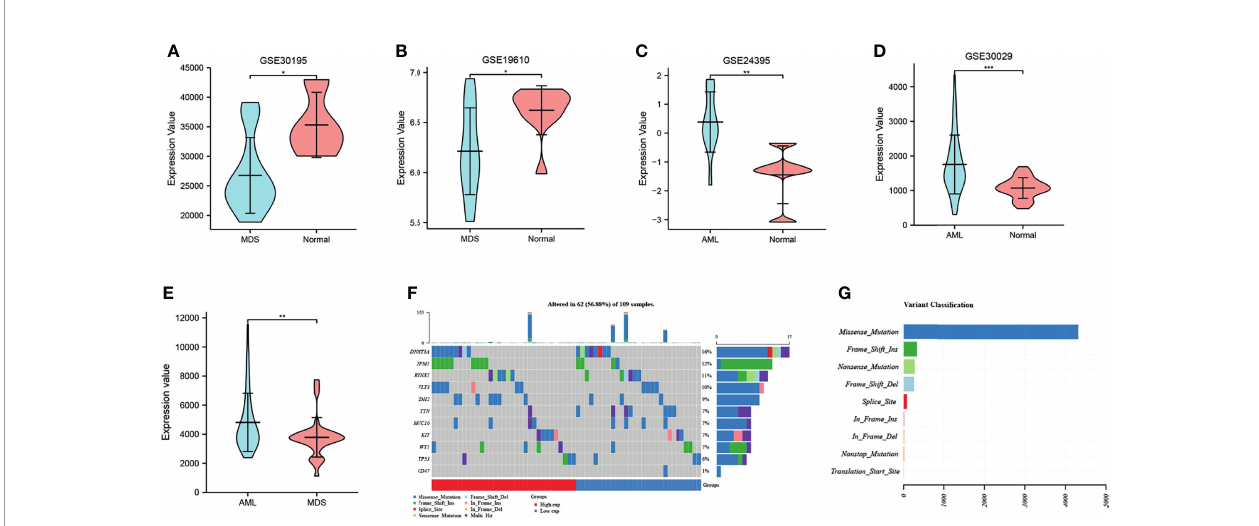
FIGURE 1 | The expression and mutation of CD47. (A, B) CD47 expression analysis in MDS and normal control samples with datasets GSE30196 and GSE19610; (C, D) CD47 expression in AML and normal control samples using the GSE24395 and GSE30029 data sets. *P < 0.05, **P < 0.01, ***P < 0.001. (E) expression level of CD47 in AML and MDS. (F) Oncoplot shows the somatic landscape of acute myeloid leukemia. (G) Variant classi fi cation of CD47